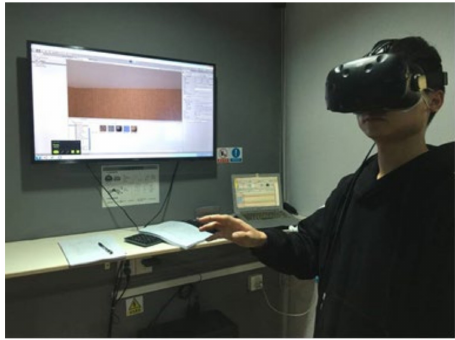
Figure 2. A participant Wearing VR